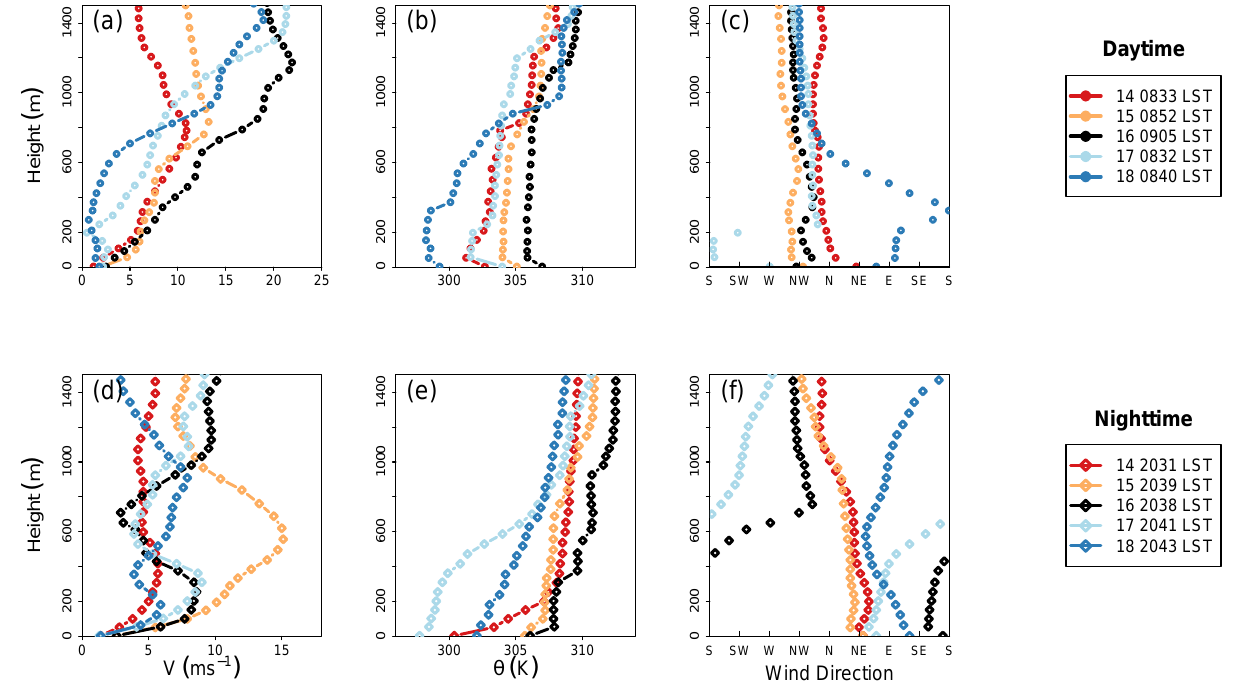
Figure 8. Vertical profiles of ( a , d ) wind speed ( V ), ( b , e ) air potential temperature ( θ ), and ( c , f ) wind direction during the day (top) and night (bottom) from SBSM atmospheric